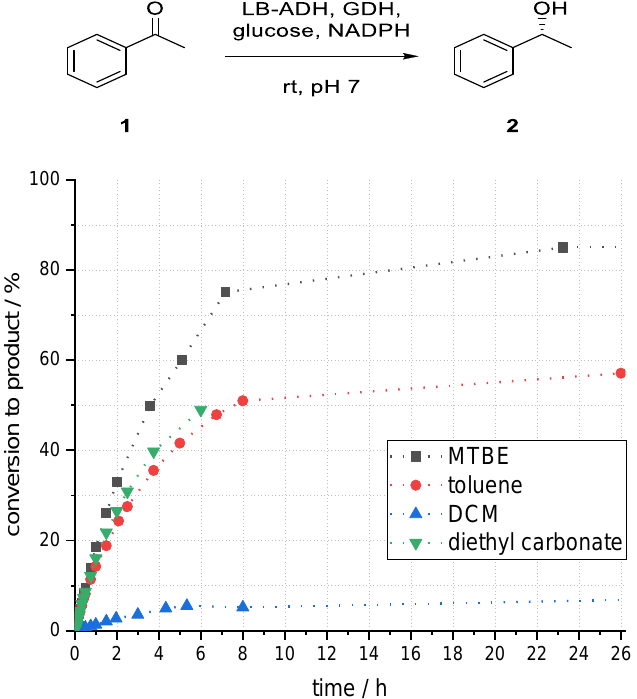
Figure 6. Influence of different solvents on the conversion to phenylethanol ( R )- 2 in an enzymatic reduction of acetophenone ( 1 ) using ADH in superabsorber-immobilized aqueous phase.